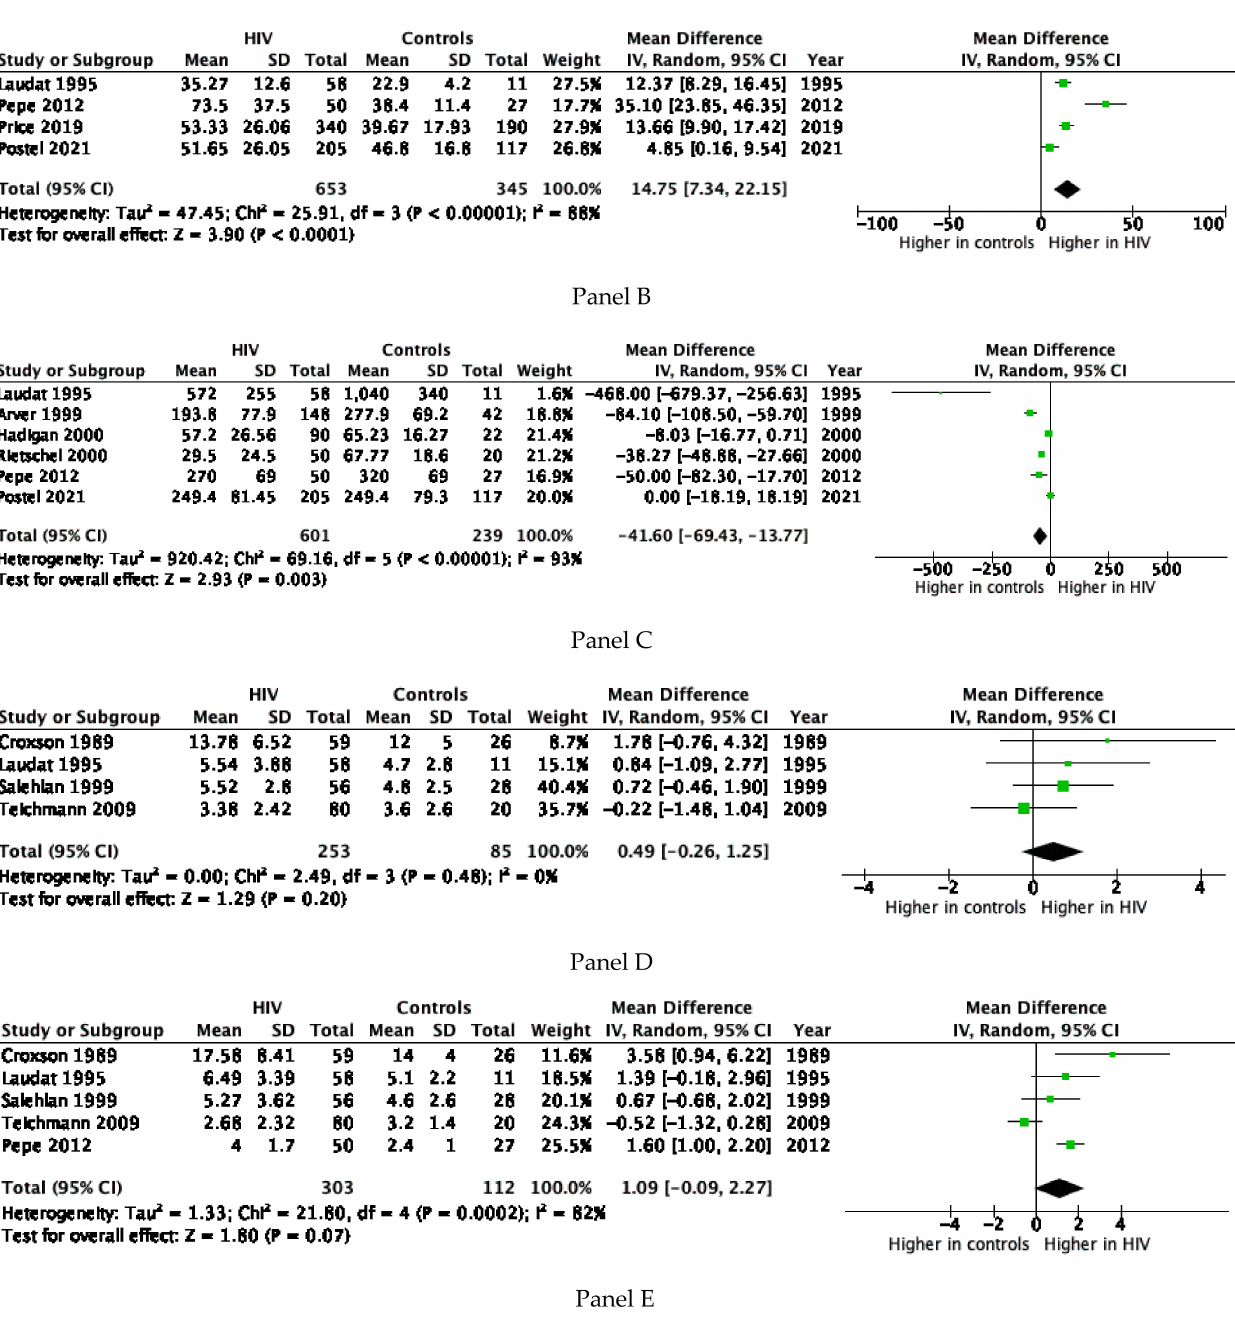
Figure 3. Forest plot comparing HIV-infected patients and controls detected in the first literature search for total testosterone serum levels (panel A ), sex hormone binding globulin (SHBG) (panel B ), free testosterone (Panel C ), follicle stimulating hormone (FSH) (panel D ), and luteinising hormone (LH) (panel E